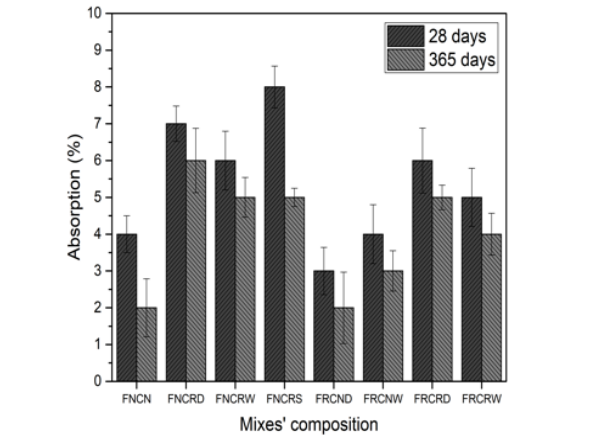
Figure 6. Absorption of water from the blocks at 28 and 365